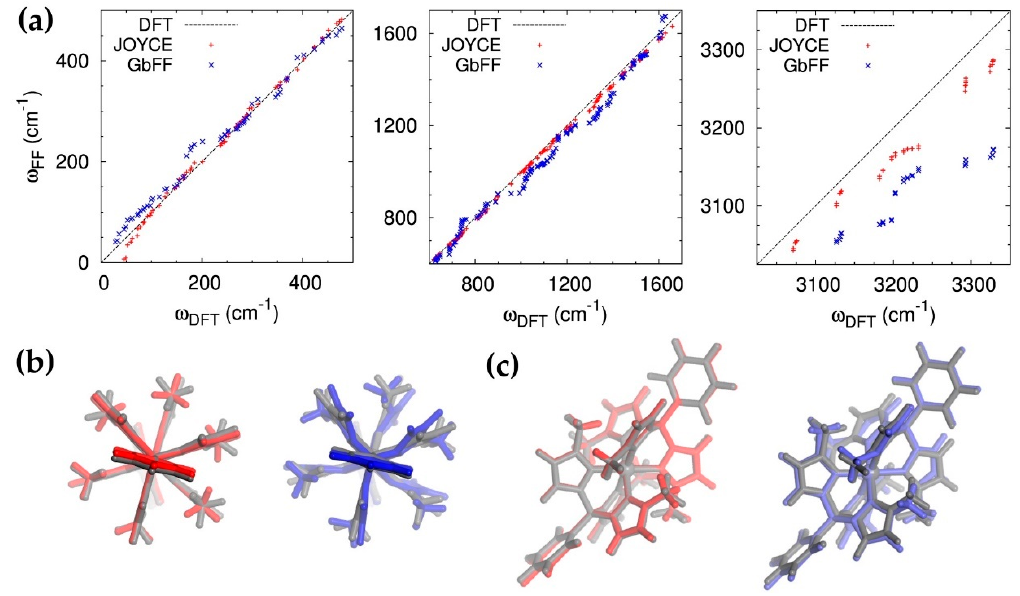
Figure 3. Comparison of the DFT vs J OYCE /GbFF relaxed geometrical properties: ( a ) correlation plot between QM vs MM/J OYCE and MM/GbFF structures vibrational frequencies as computed at the B3LYP*/6-311G* level of theory for low (0–500cm − 1 ), medium (600–1700cm − 1 ) and high (3050-3350 cm − 1 ) frequencies from left to right top panels. It might be worth noticing that the x,y scale in last panel was increased with respect to the former, to better appreciate J OYCE and GbFF differences; ( b ) Top and ( c ) side views of the overlap of QM (dark grey) and MM/J OYCE (red) and MM/GbFF (blue) optimized geometries.